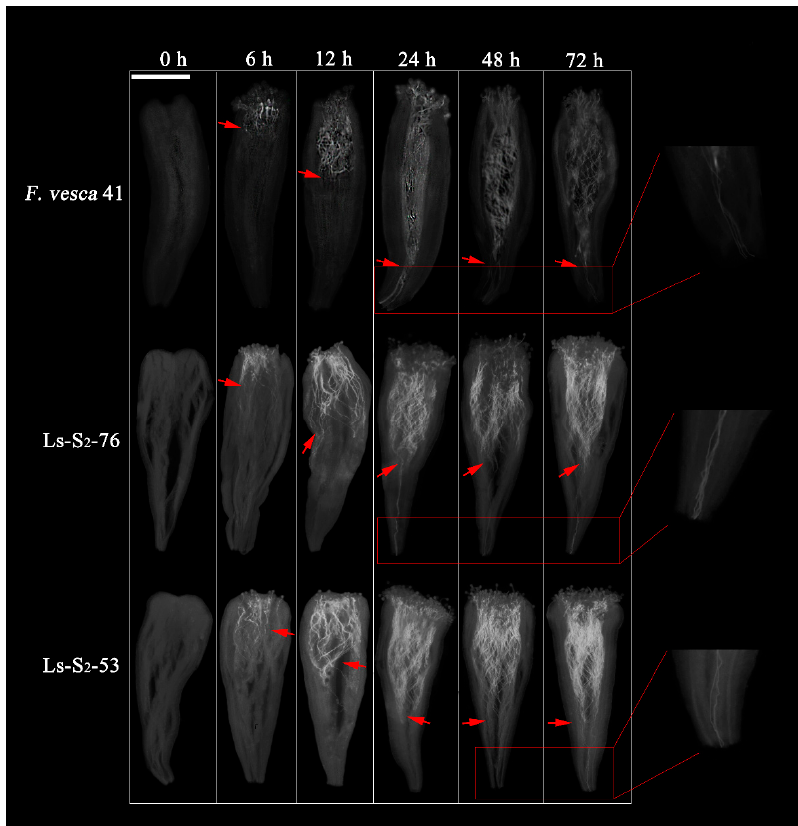
Figure 2. Results of dynamic observation of pollen tube growth in styles. Times of 0, 6, 12, 24, 48, and 72 h each indicate the growth state of the pollen tubes of F. vesca 41, Ls-S 2 -76, and Ls-S 2 -53 after manual self-pollination. The locations indicated by red arrows are where most of the pollen tubes arrived. The red squares indicate the details of the style basis passed by pollen tubes at different time in different samples. Scale bar = 0.5 mm. The growth rate of the pollen tubes was similar within 12 h between the three different samples, and reached about 1/3 of the style at 12 h. Most pollen tubes of F. vesca reached the base of the styles, while those of two green strawberry lines reached 2/3 of styles at 24 h. Unlike the Ls-S 2 -53 lines, some styles of Ls-S 2 -76 were crossed by at least one pollen tube at 24 h.